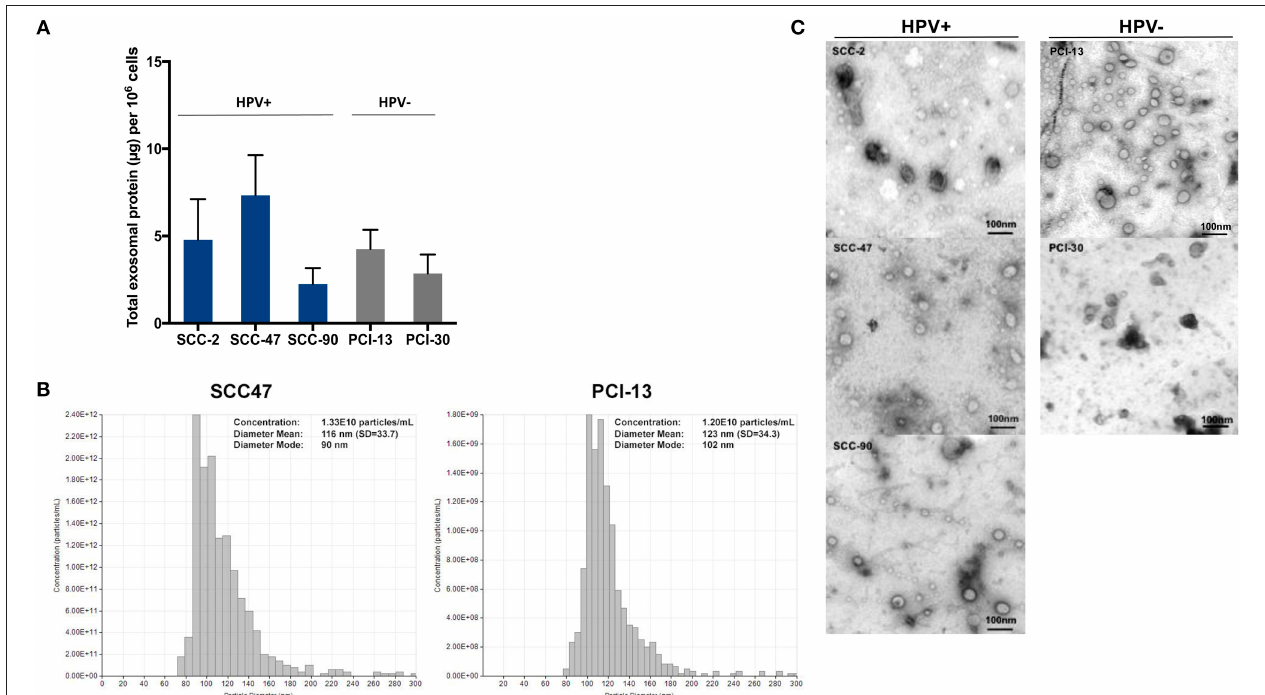
FIGURE 1 | Characteristics of HPV( + ) and HPV( − ) exosomes. (A) Total protein levels in exosomes isolated from supernatants of HPV( + ) and HPV( − ) HNC cell lines. HNC cells were plated and expanded for 48–72h to reach 80% confluence. Supernatants were collected pre-cleared by centrifugation, concentrated and 1ml of the concentrate was used for exosome isolation by mini-SEC on Sepharose 2B columns. Total protein levels were measured in fractions #4. The data are means ± SD from 5 experiments with each cell line. (B) qNano analyses of an HPV( + ) and an HPV( − ) cell lines are shown. (C) Representative transmission electron microscopy (TEM) images of exosomes in #4 fractions of HPV( + ) (SCC-2, SCC-47, SCC-90) and HPV( − ) (PCI-13, PCI-30) supernatants. Representative data are from 1/3 experiments performed with each HPV( + ) and HPV( − ) exosomes.